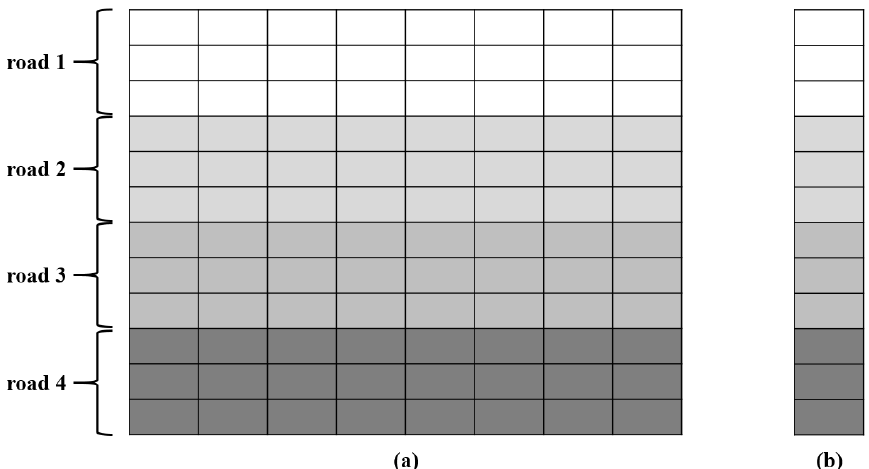
Figure 1. Two popular types of state representation in an intersection with four roads (in four different colors) and three lanes in each road: ( a ) DTSE matrix—Each cell represents one vehicle; ( b ) Feature-based state vector – Each cell represents a lane